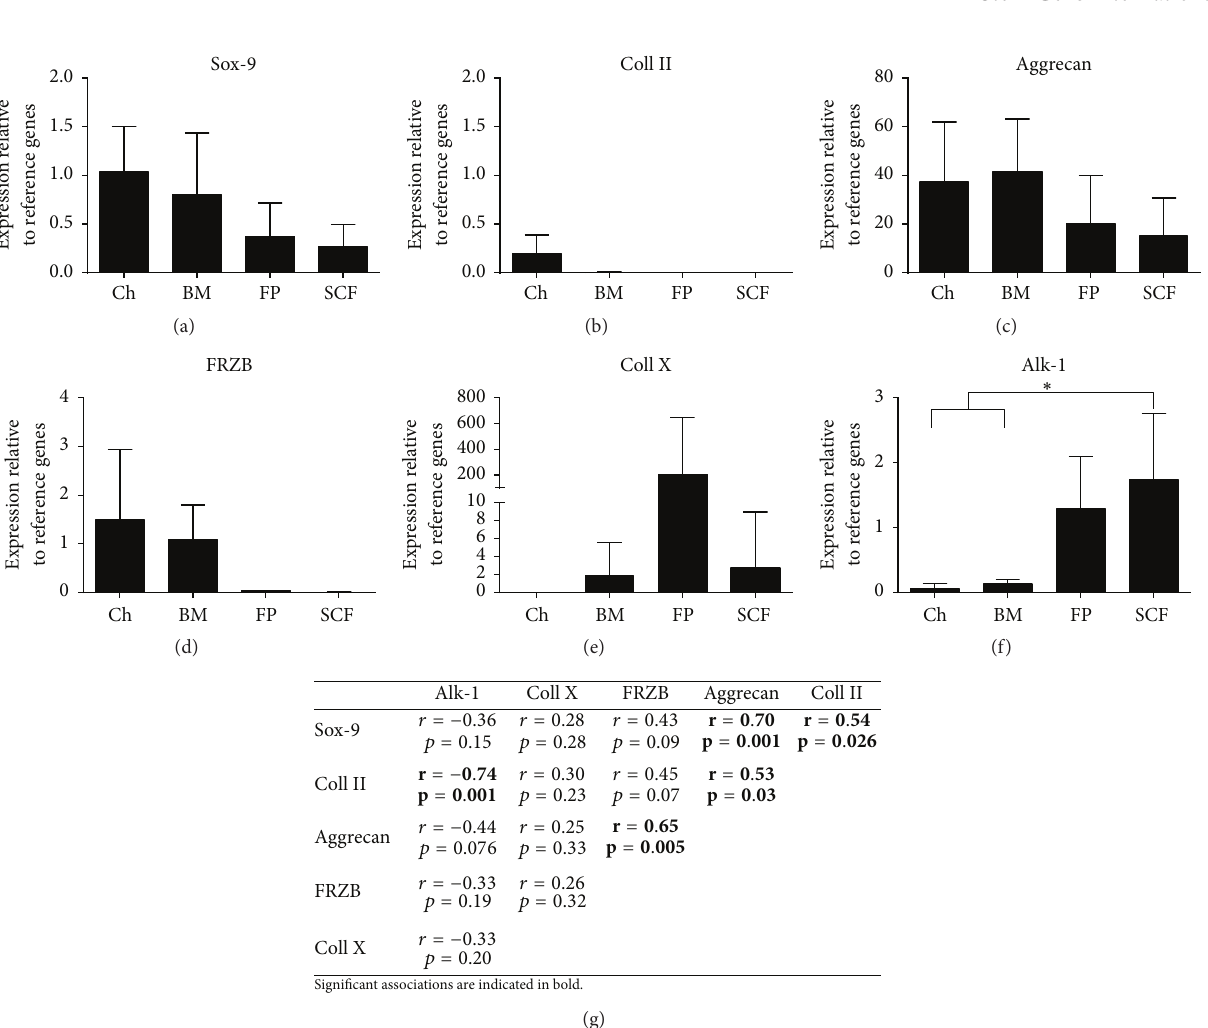
Figure 1: The expression of chondrogenic and hypertrophic genes in monolayer cell populations prior to chondrogenesis. ((a)–(f)) Chondrocytes (Ch), bone marrow MSC (BM), fat pad MSC (FP), and subcutaneous fat MSC (SCF). Data shown are the means ± the standard deviation of triplicate runs and 5 donors for each cell population. One-way ANOVA and post hoc Bonferroni tests were used to test for significant differences in gene expression levels between cell types. (g) Pearson’s correlation analysis matrix comparing genes which may be predictive of chondrogenic potential; significant correlations are in bold. Gene expression is expressed relative to the reference genes PPIA and